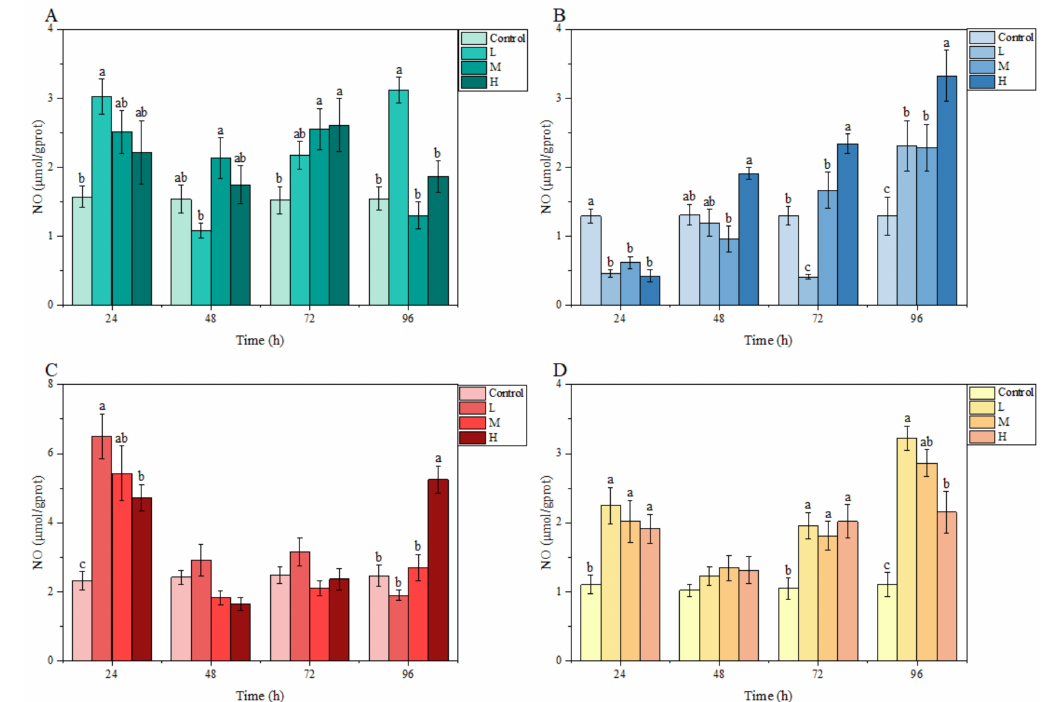
Figure 5. Effects of ammonia stress on NO content of juvenile M. salmoides. ( A – D ) represent the NO content in the gill, brain, liver, and kidney, respectively. The bars represent the mean ± S.D. ( n = 3). Different letters indicate statistical differences ( p < 0.05).